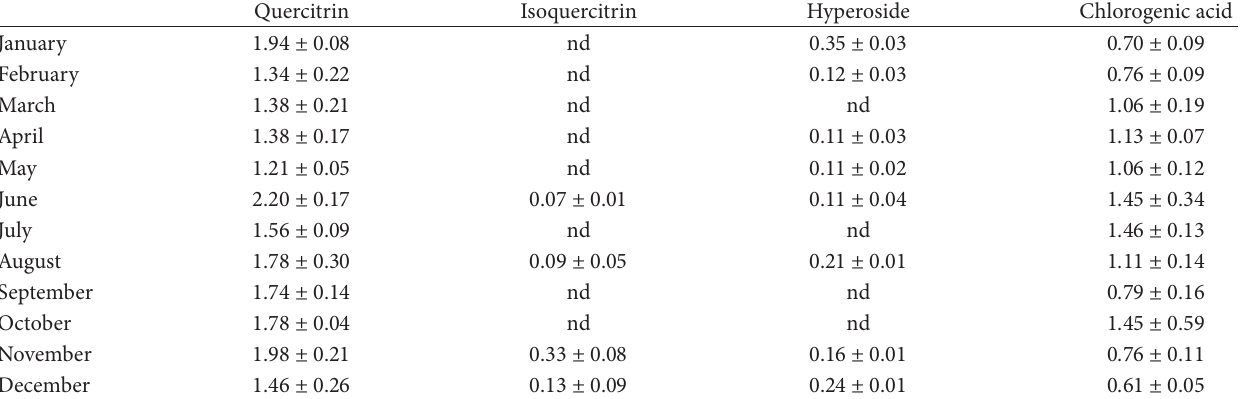
Table 2: Content of individual polyphenol during the year in the leaves of A. unedo expressed in mg per g of dry